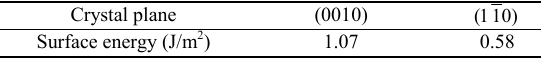
Fig. 6 Crystal structure of Al 4 SiC 4 . Table 3 Surface energy of different